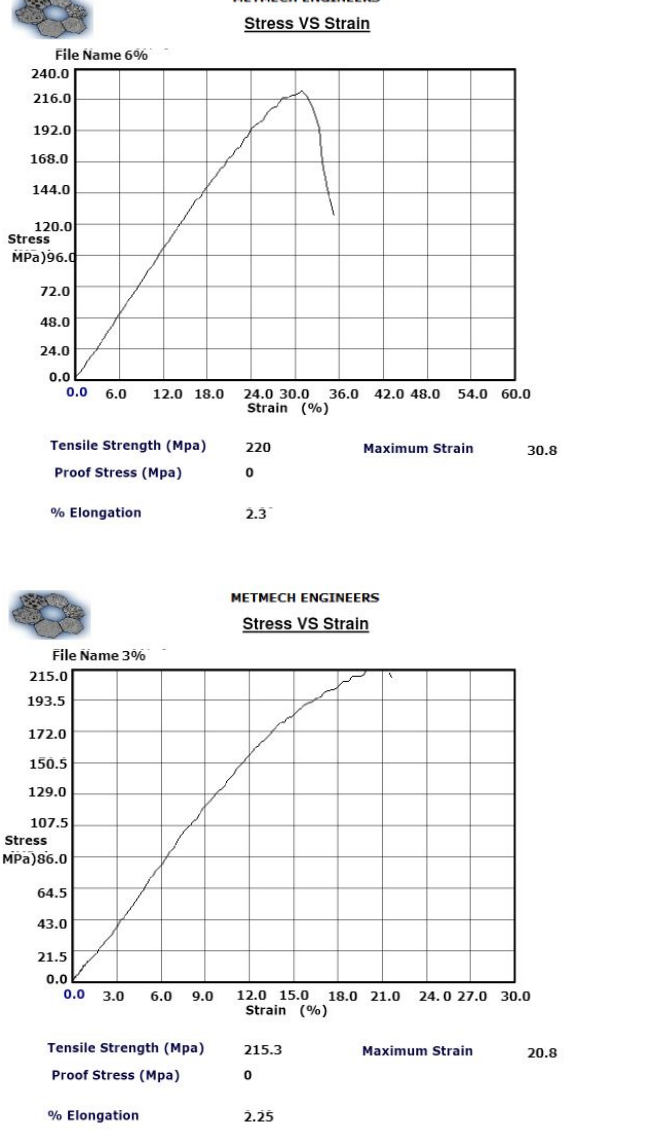
Figure 12. Sample stress–strain curves of tensile test Fig 12 Sample Stress-Strain Curves of Tensile Test Specimens